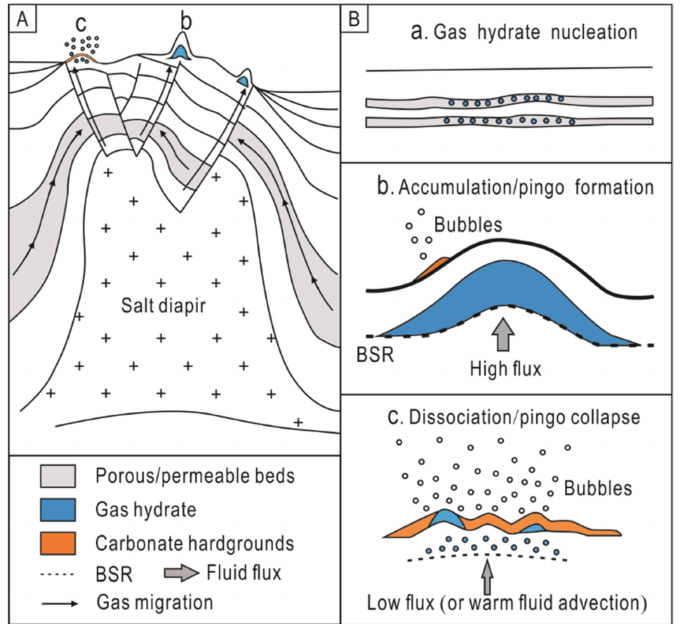
Figure 16. ( A ) Conceptual model of the plumbing system with related faulting along the salt diapir flanks promoting thermogenic gas migration and the resulting hydrate pingoes. ( B ) Hydrate pingo evolution is closely related to the nucleation, accumulation, and dissociation of near-seafloor hydrates, most likely due to fluid flux variation (cited from [92]).